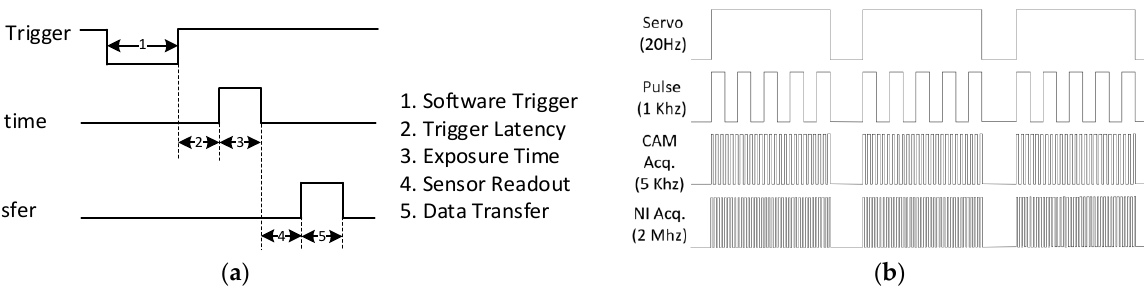
Figure 7. Software trigger timing: ( a ) camera timing; ( b ) acquisition and control timing.